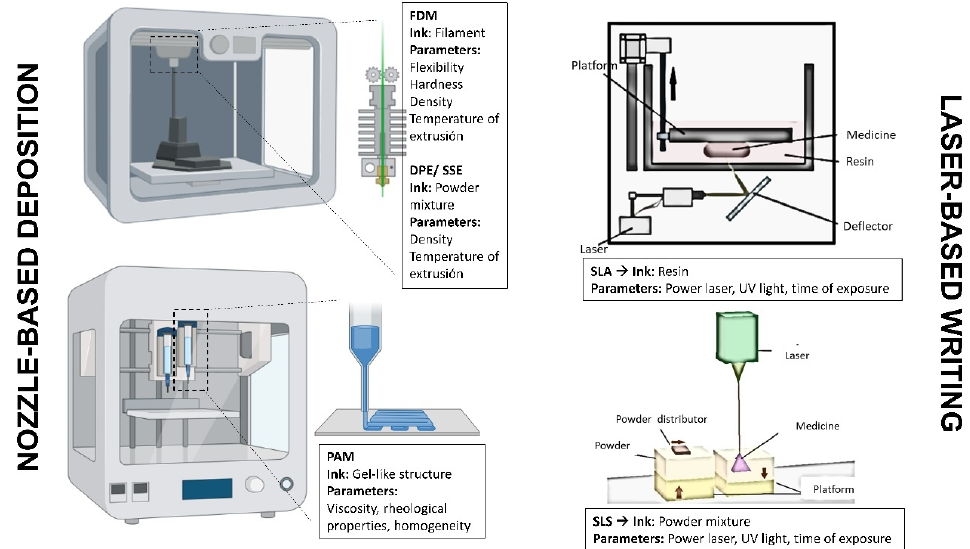
Figure 4. Types of 3D printing techniques commonly used in the manufacture of personalized medicines. Key: fuse deposition modelling, FDM; direct powder extrusion, DPE; semisolid extrusion, SSE; pressure-assisted microsyringes, PAM; stereolithography, SLA; selective laser sintering, SLS.